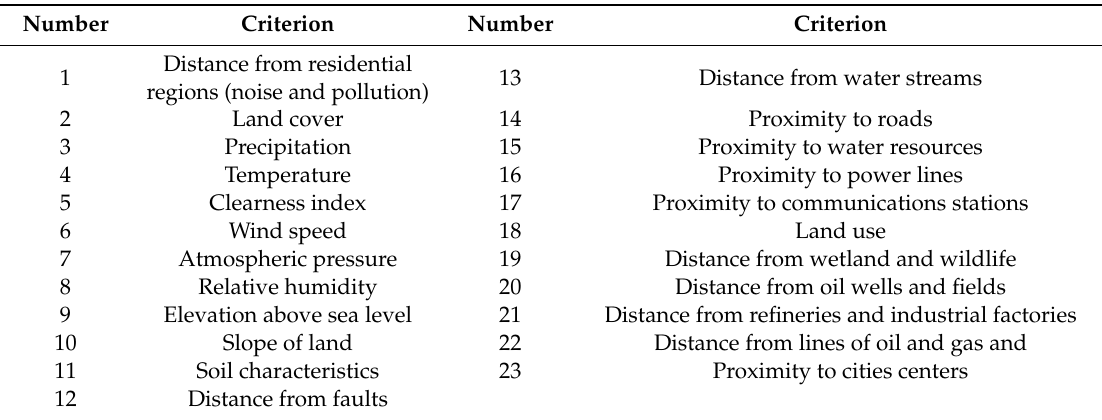
Table 1. Criteria of study zone.